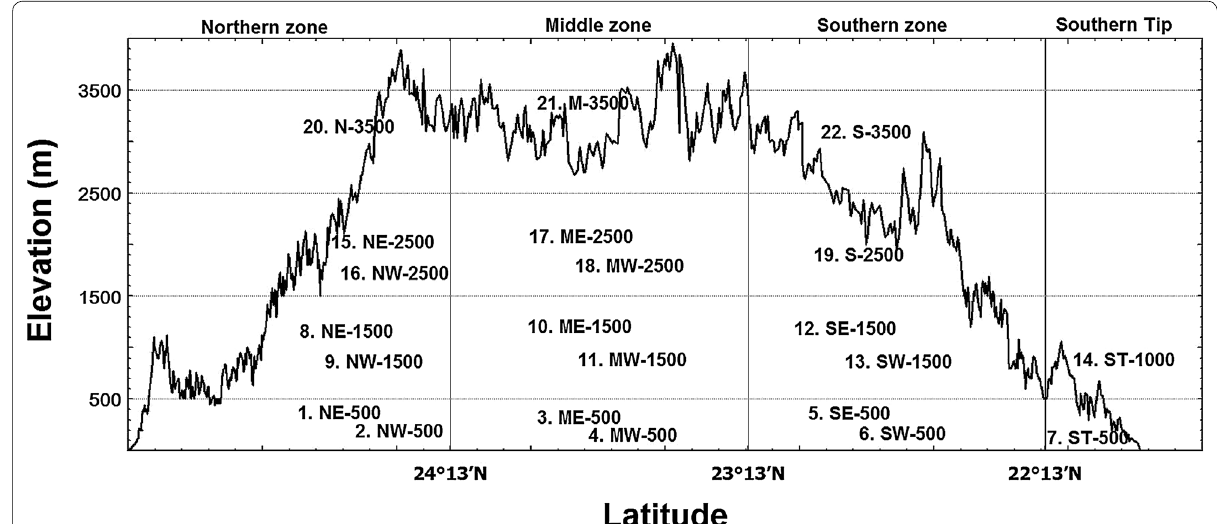
Fig. 1 The numbers and acronyms of 22 geographical localities of Taiwan (GLTs). The solid curve represents the profile of the island. Taiwan was divided into four latitude zones, northern zone (N), central zone (C), southern zone (S), and southern tip (ST). The N, C and S latitude zones were divided into eastern (E) and western (W) slopes of central mountain system. Seven geographical areas were obtained, they were NE, NW, CE, CW, SE, SW and ST. The seven geographical areas were then divided into several geographical localities according to elevation. The GLTs were numbered from north to south and from low to high